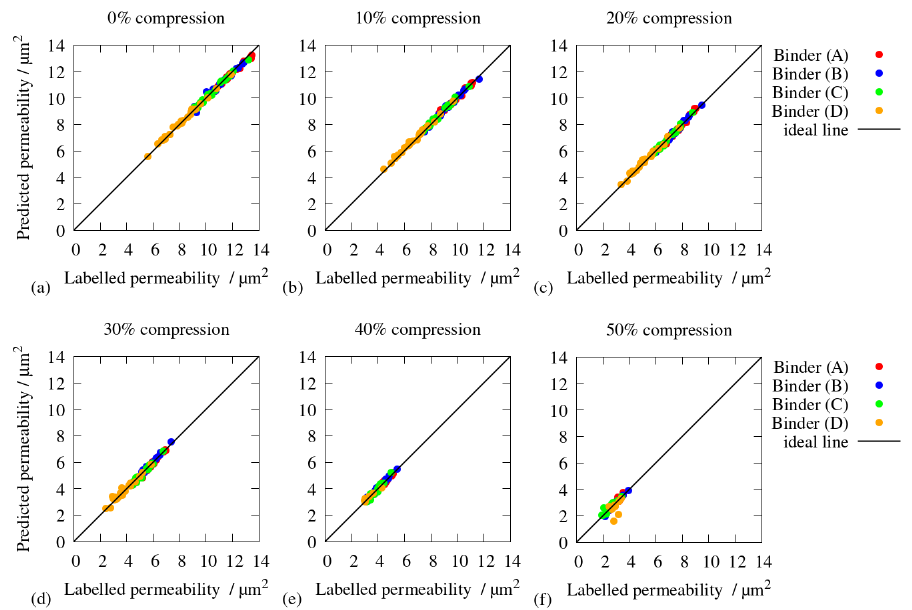
Figure 7. Predictions on the training and validation data, colored according to the binder width b r ; see Figure 3; ( a ) uncompressed; ( b ) 10% compression; ( c ) 20% compression; ( d ) 30% compression; ( e ) 40% compression; ( f ) 50% compression.